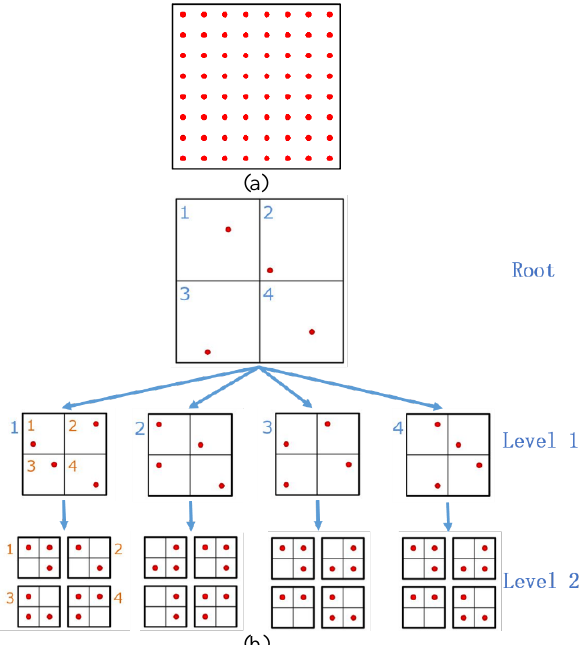
Figure 4. Potree’s octree structure explained in 2D: (a) Raw data; (b) the octree structure with a root with subsampling point and level 1 and level